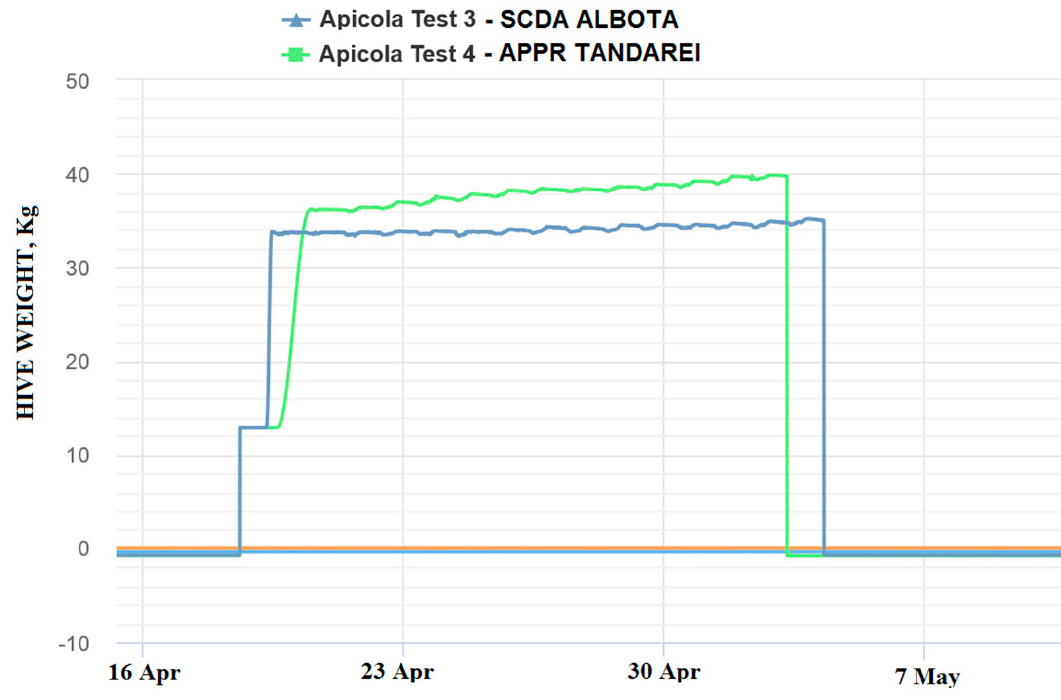
Figure 4. The weight gain (kg) monitored by experimental electronic hives in the rape honey flow in two locations (Albota and Tandarei) from 20 April to 5 May